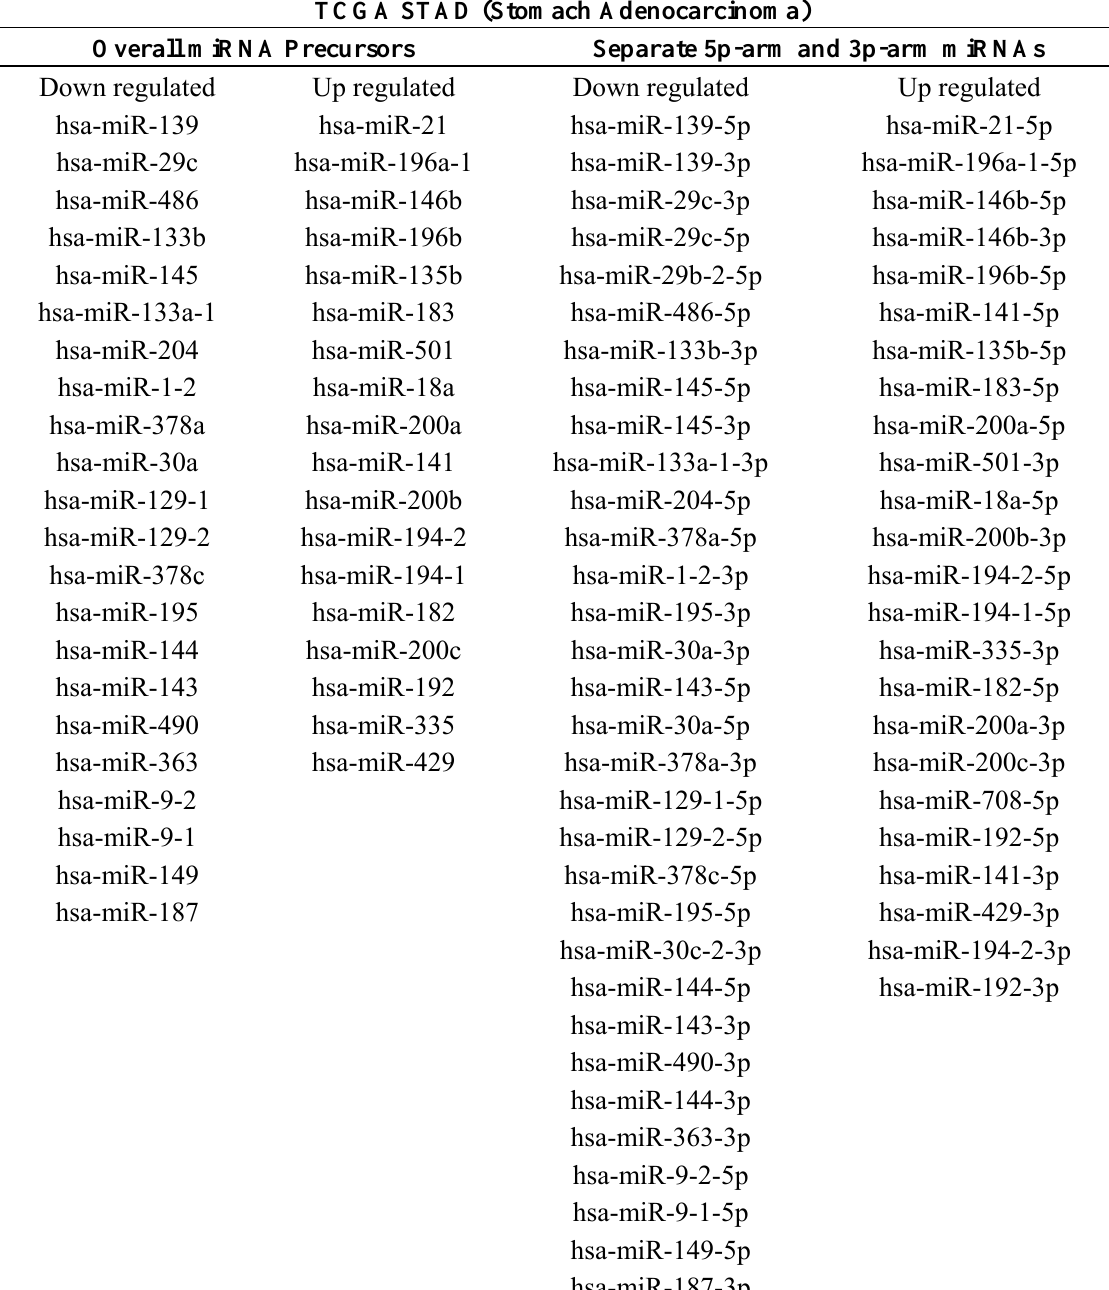
Table 1. Dys-regulated miRNAs in TCGA (the Cancer Genome Atlas) STAD gastric cancer